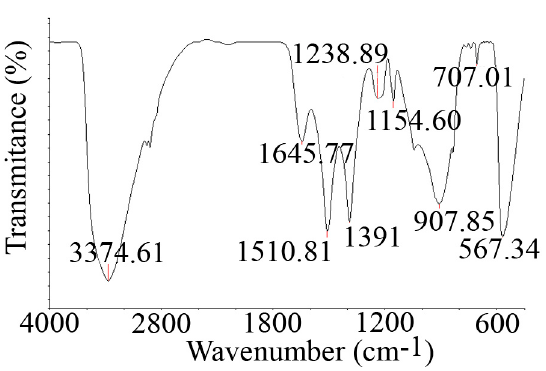
Figure 1. Fourier transform infrared (FTIR) spectrum of the zinc oxide (ZnO) nanorods.